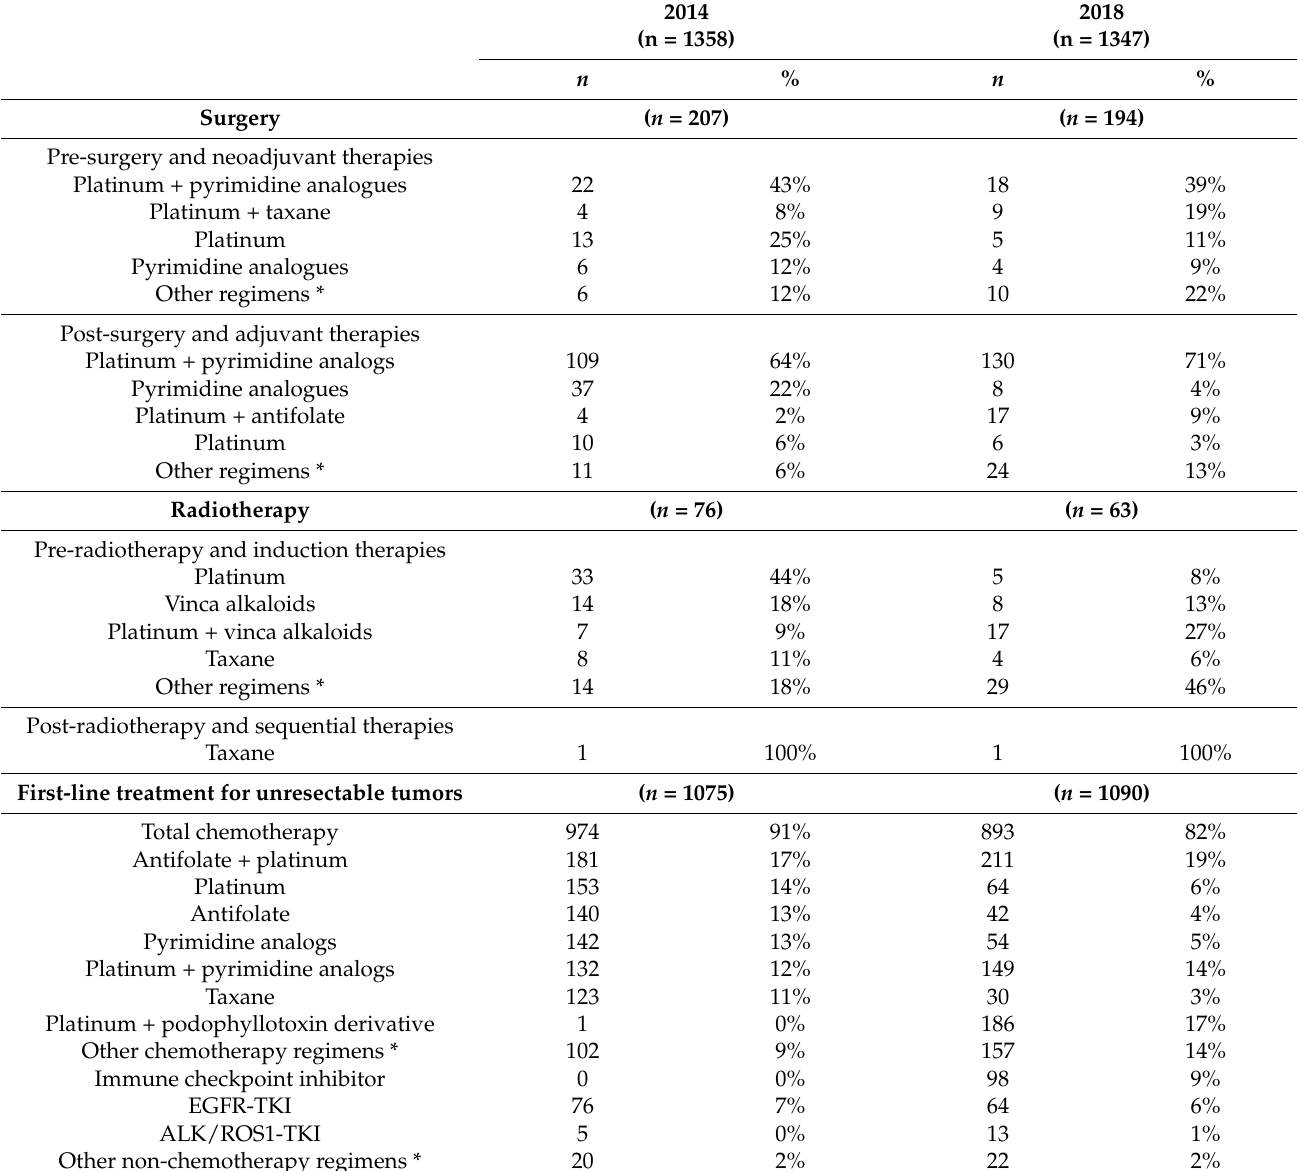
Table 3. Pharmacological treatments initiated in 2014 versus 2018 by treatment